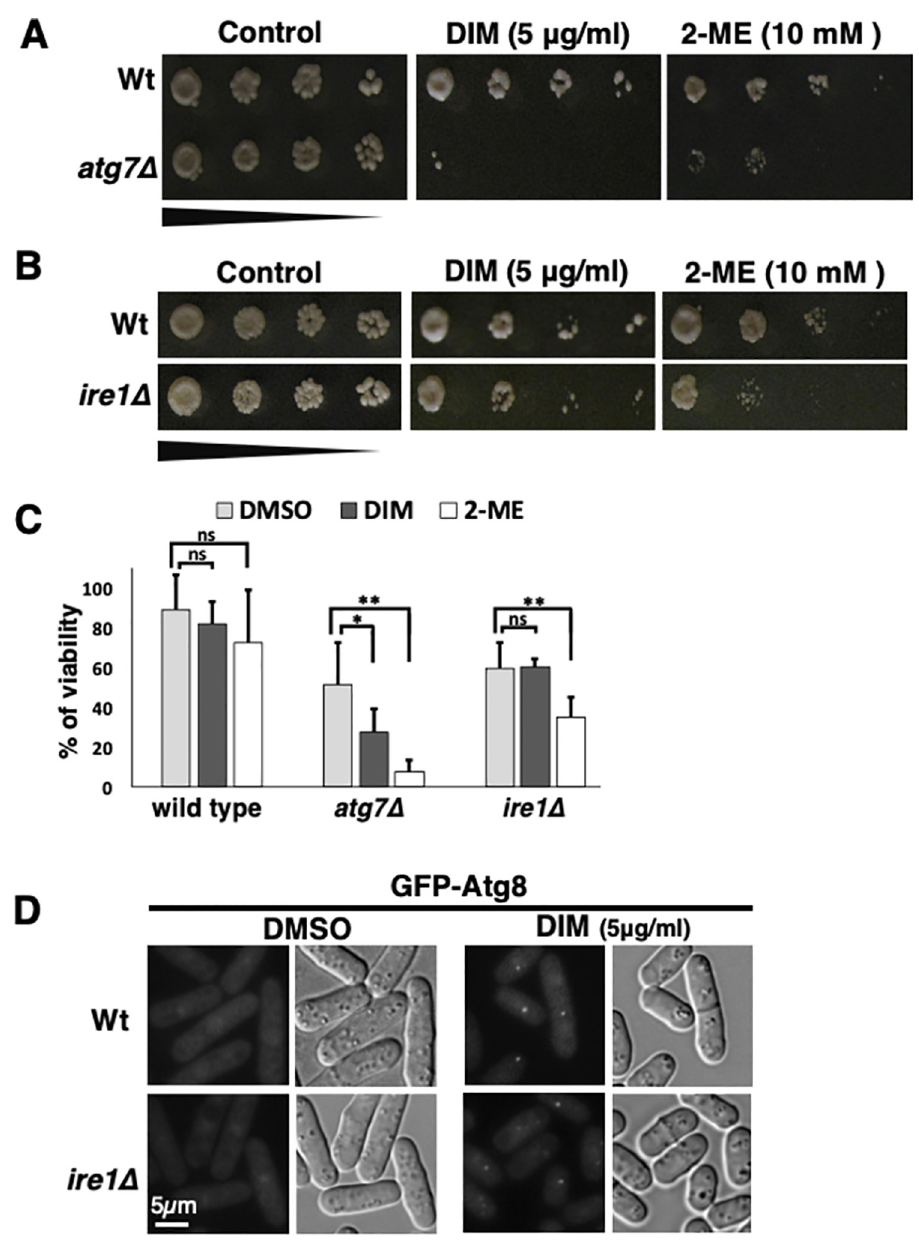
Fig 6. Autophagy pathway, but not ER stress response pathway, is required for the resistance to DIM. (A-C) Viability of log-phase cells of wild-type (Wt), atg7 Δ (A) and ire1 Δ (B) were studied by spot assay with five-fold serial dilutions in the presence of 5 μ g/ml 3,3’-Diindolylmethane (DIM) or 10 mM 2-mercaptoethanol (2-ME). The images were taken 3–5 days after spotting. The percentages of viability are shown in C. (D) Autophagy induction by DIM was studied using ire1 Δ mutant expressing GFP-Atg8. The experiment was performed as shown in Fig 5. See materials and methods for details. fragmentation (Fig 3C and 3D). Our results for cell killing and nuclear fragmentation strongly suggested that DIM induces apoptosis at 20 μ g/ml concentration (Fig 3). The acute viability assay showed that 10 minutes of treatment with 20 μ g/ml of DIM is enough to trigger cell kill- ing (Fig 2A and 2B). The cells were not stained with ethidium bromide just 10 minutes after